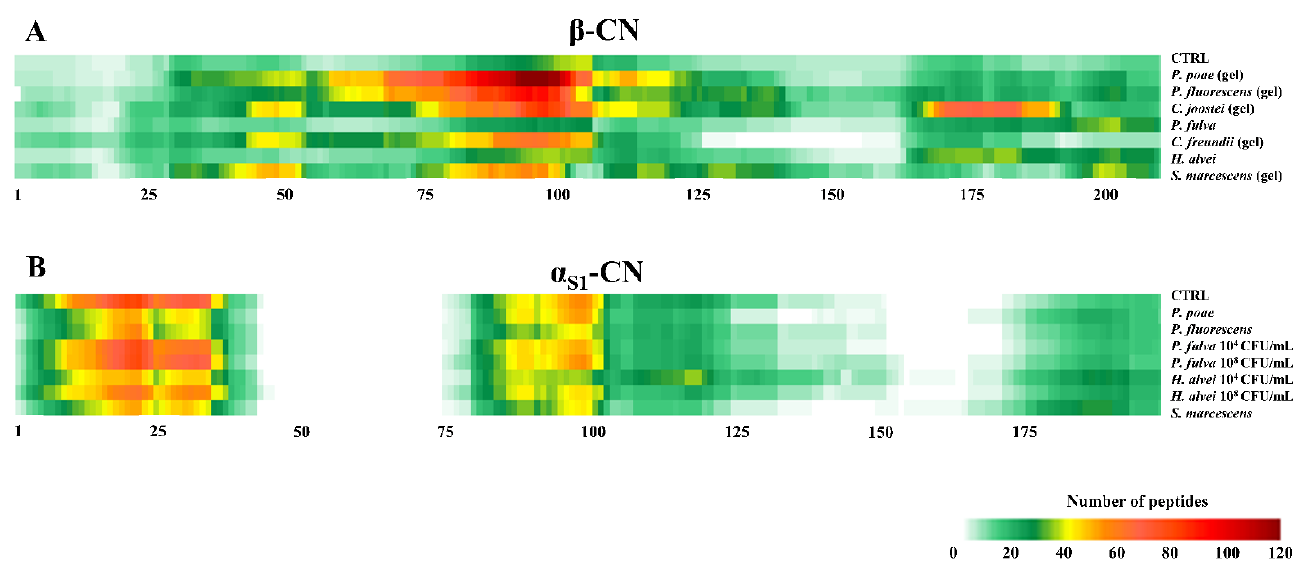
Figure 4. Qualitative visualization of proteolytic patterns of: ( A ), β -CN in sterilized samples. From the top: CTRL sterilized milk, sterilized milk inoculated (10 8 CFU/mL) with P. poae, P. fluorescens, C. joostei, P. fulva, C. freundii, H. alvei, and S. marcescens ; ( B ) α S1 -CN in sterilized samples, which did not show sedimentation or gelation during incubation at 45 °C for 100 days. From the top: CTRL sterilized milk, sterilized milk with P. poae, P. fluorescens, P. fulva, H. alvei, and S. marcescens. (CFU/mL: the bacterial count of pasteurized milk before in-batch sterilization). The color code from green to red indicates the frequency at which an amino acid was identified within the β-CN and α S1 -CN sequences and gaps are regions where no peptides were identified.